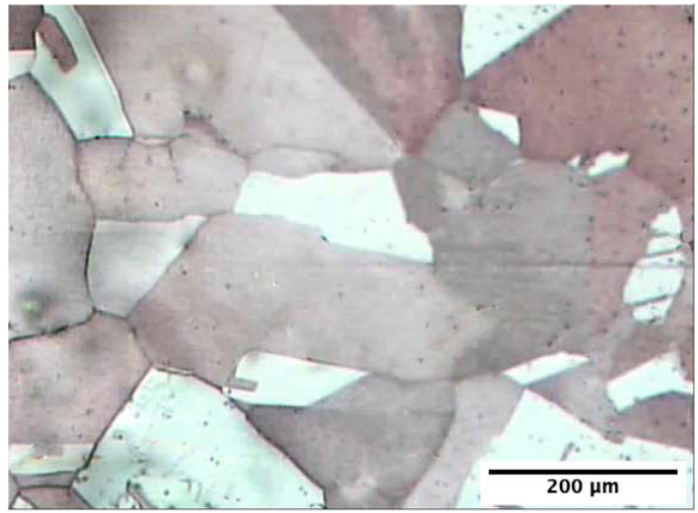
Figure 17. Optical microscope image of as annealed copper sheet.